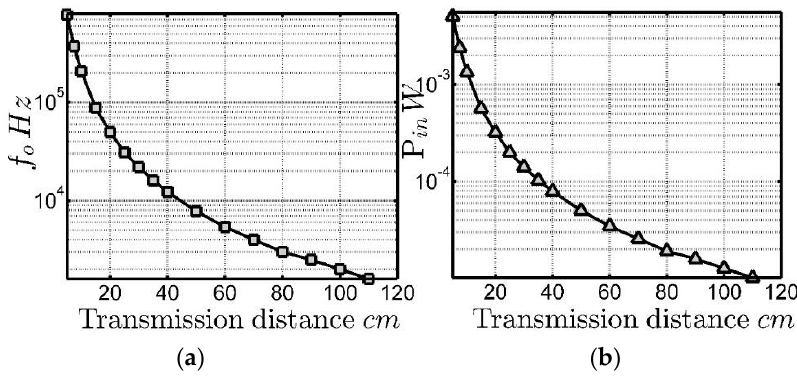
Figure 3. Experimental setup. Estimated 𝑓 𝑂 and optical power under various link distance: ( a ) LTF output frequency versus link distance; ( b ) optical input power versus link distance.